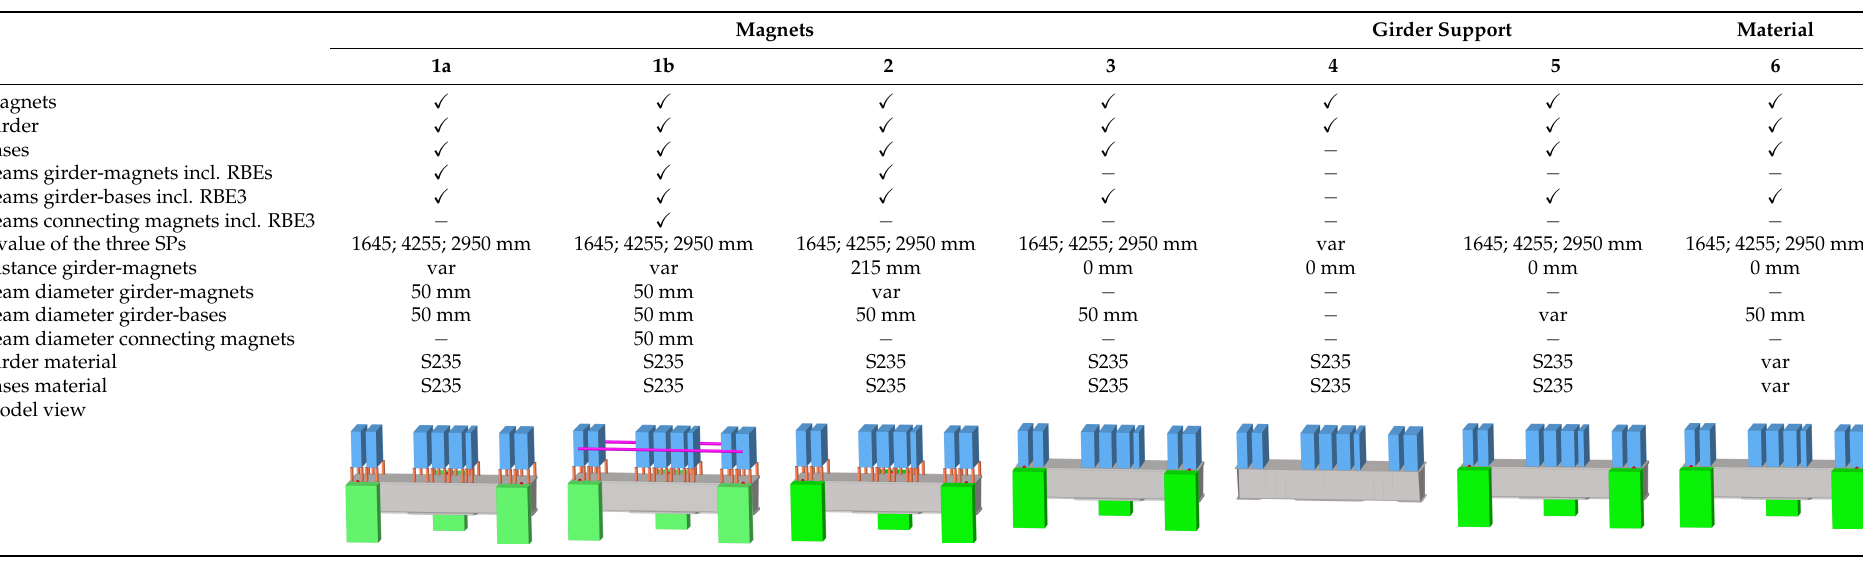
Table 2. Parametric study components and properties defined for the models 1a: Magnet position height, 1b: Magnet position height and connection, 2: Stiffness of the magnet–girder connection, 3: Magnet mass, 4: Girder support point (SP) position, 5: Stiffness of the girder support, and 6: Material properties. Different components or properties are part of the corresponding models (check mark) or not part of them (minus sign). ‘var’ means that the corresponding component or property was varied within the model. Magnets Girder